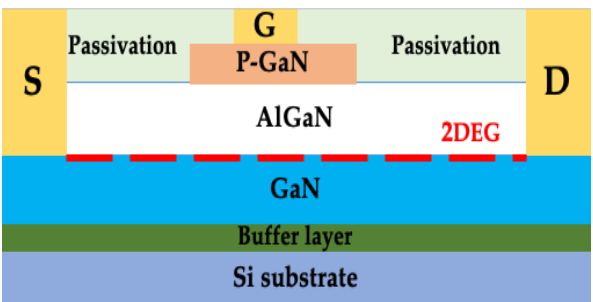
Figure 1. Most favorable schematic cross section of the E-mode GaN High Electron Mobility Transistor (HEMT) with p-GaN